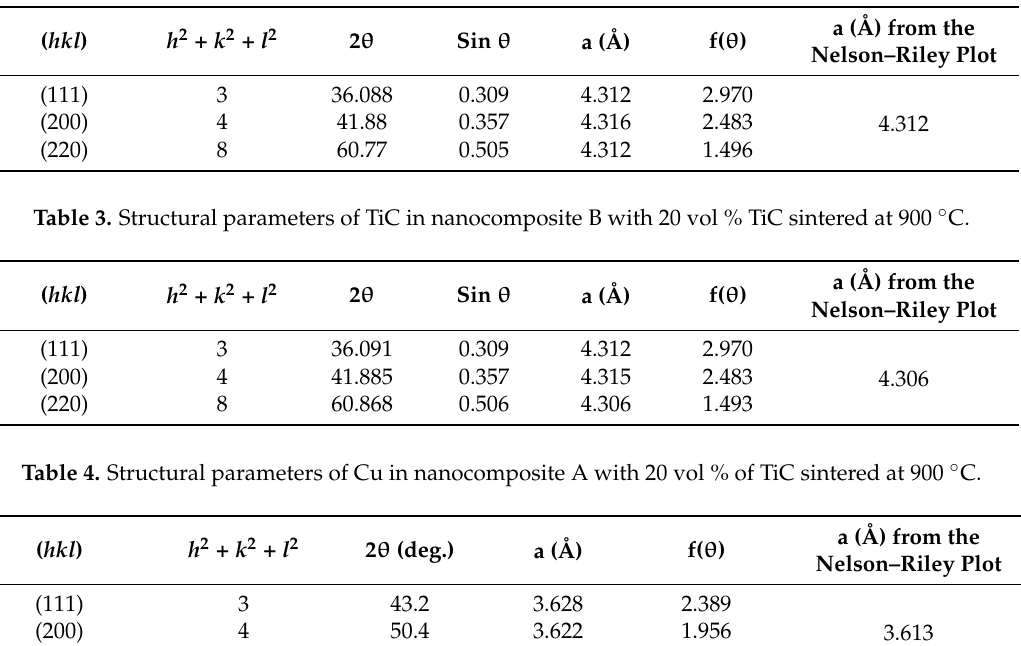
Table 2. Structural parameters of TiC in nanocomposite A with 20 vol % TiC sintered at 900 ◦ C.